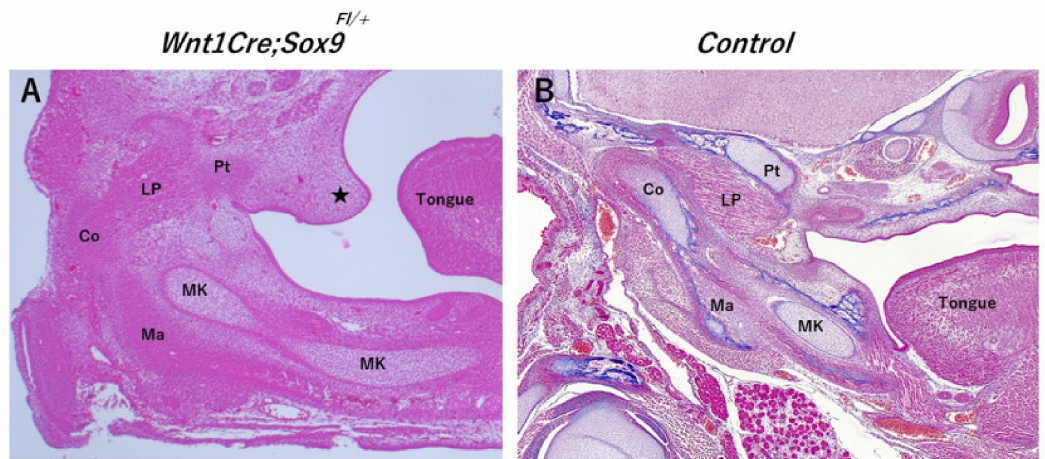
Figure 1. Histological view of WntCre;Sox9fl/+ mice. ( A ) WntCre;Sox9fl/+ mice, ( B ) control mice (C57BL/6J). Deficiency of Sox9 in neural crest-derived cells (Wnt1-positive) results in hypoplasia of the condylar head (Co), mandible (Ma) and lateral pterygoid (LP) in the temporomandibular joint area ( A ). Deficiency of Sox9 in neural crest-derived cells (Wnt1-positive) also results in poor fusion of the palate (( A ); black star). Co: condylar head, LP: lateral pterygoid, Ma: mandible, MK: Meckel’s cartilage, Pt: pterygoid